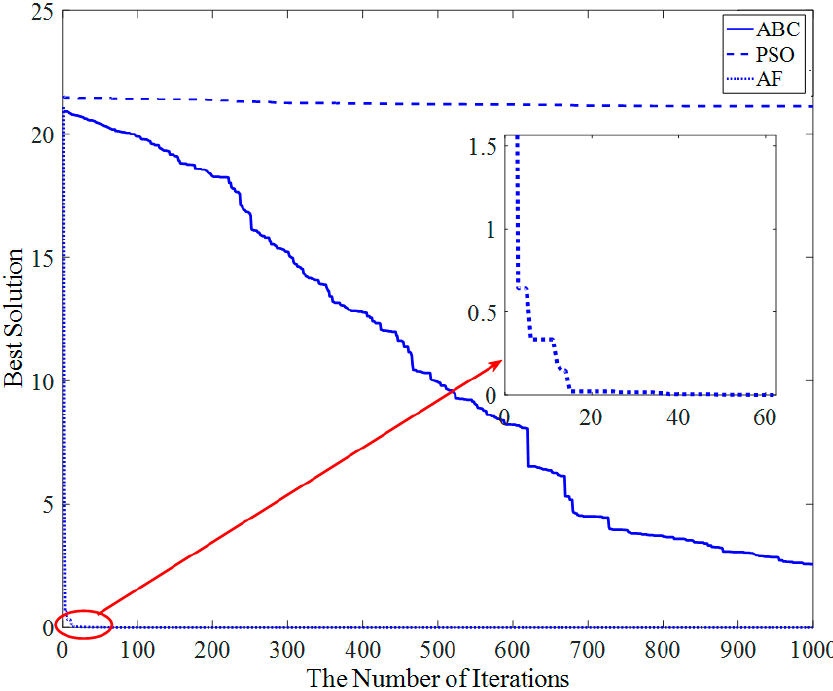
Figure 20. The convergence curve of the three algorithms for Ackley function in 100-dimensional space.